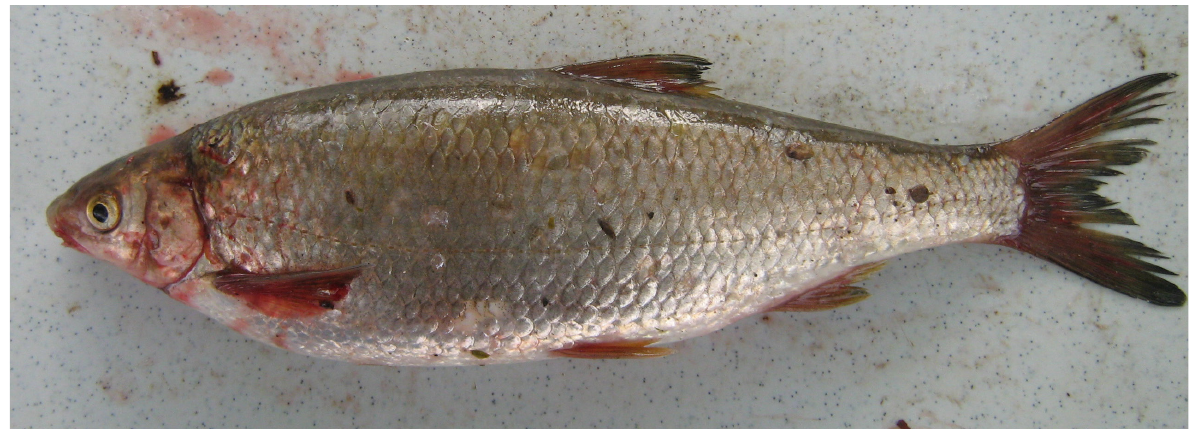
Fig. 1. Neretva nase, Chondrostoma knerii , 29 cm TL from the lower Neretva River, Bosnia and Herzegovina (Photo by Pero Tutman, October